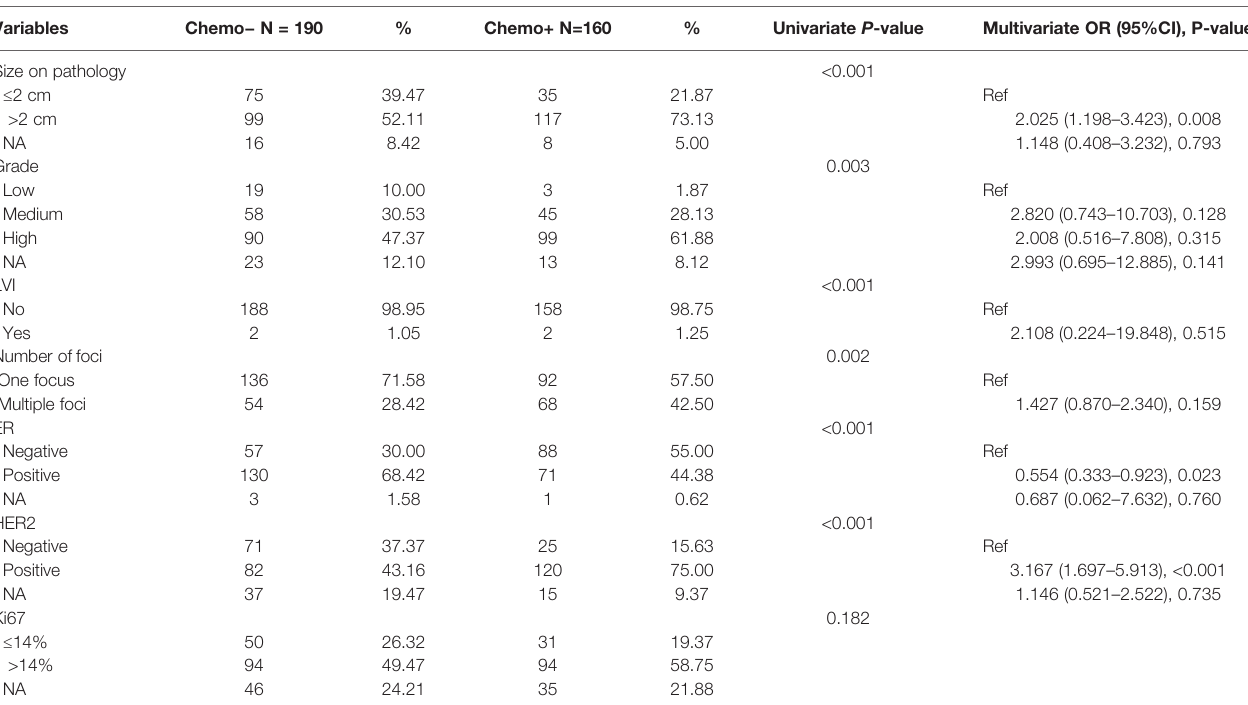
TABLE 3 | Univariate and multivariate analysis of impact factors on chemotherapy in DCISM patients with negative axillary.